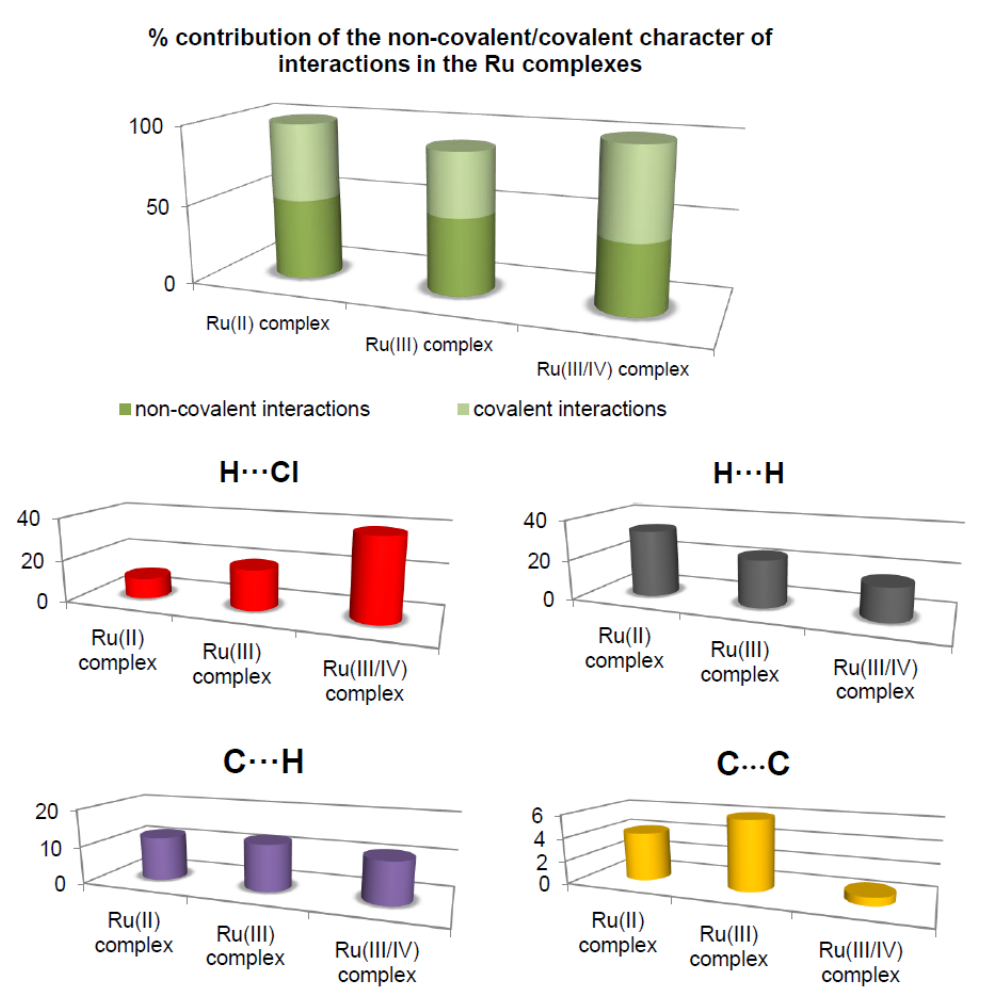
Figure 3. Comparison of the percentage of contribution of important contacts for the ruthenium complexes.